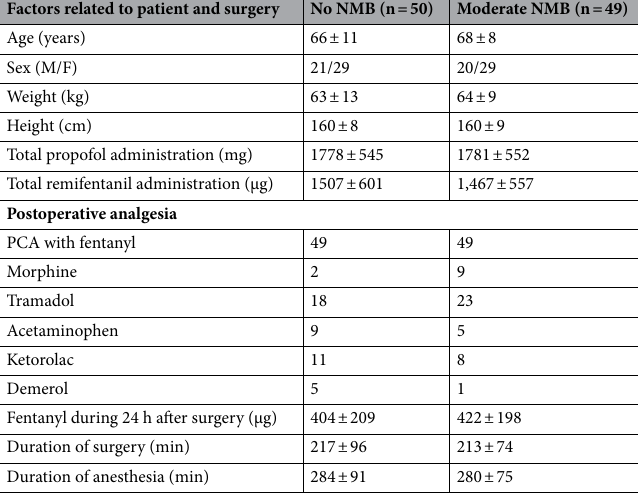
Table 1. Patient characteristics and surgery-related data. Values are means ± SD or number of patients. NMB neuromuscular blockade, PCA patient-controlled analgesia.